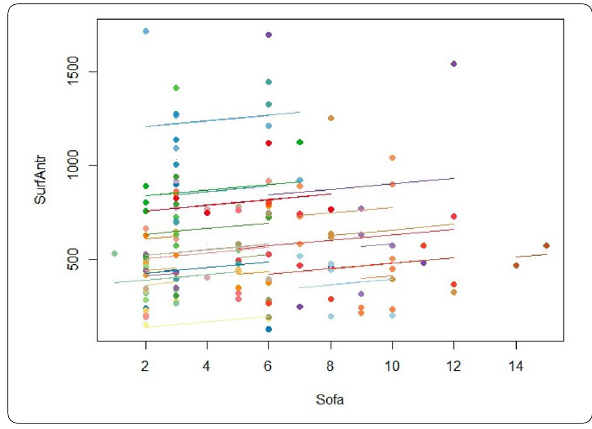
Figure 1 FC‑186 Extravascular lung water predicts progression to acute respiratory distress syndrome in critically ill cirrhotic patients SCHOULMANN Alix 1 , PLATTIER Rémi 1 , ANTY Rodolphe